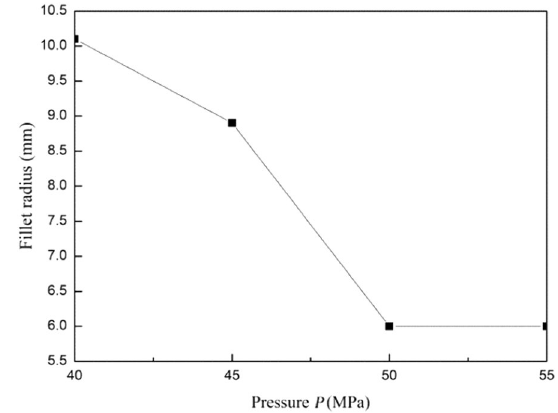
Figure 14 Fillet radius at different internal